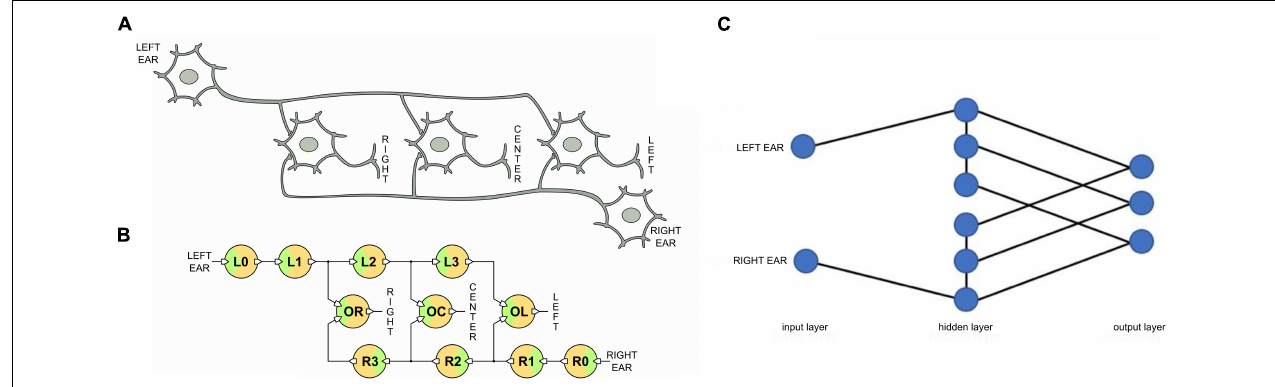
FIGURE 4 | (A) Schematic neuron network of the Jeffress model. (B) Corresponding spiking neural network implemented with UCN blocks. (C) SNN architecture. The Jeffress model is neither a simple feed-forward nor a recurrent neural network due to the intra-layer connections. Also notice if the hidden layers were redefined, there would be connections toward the output layer that need to skip layers.